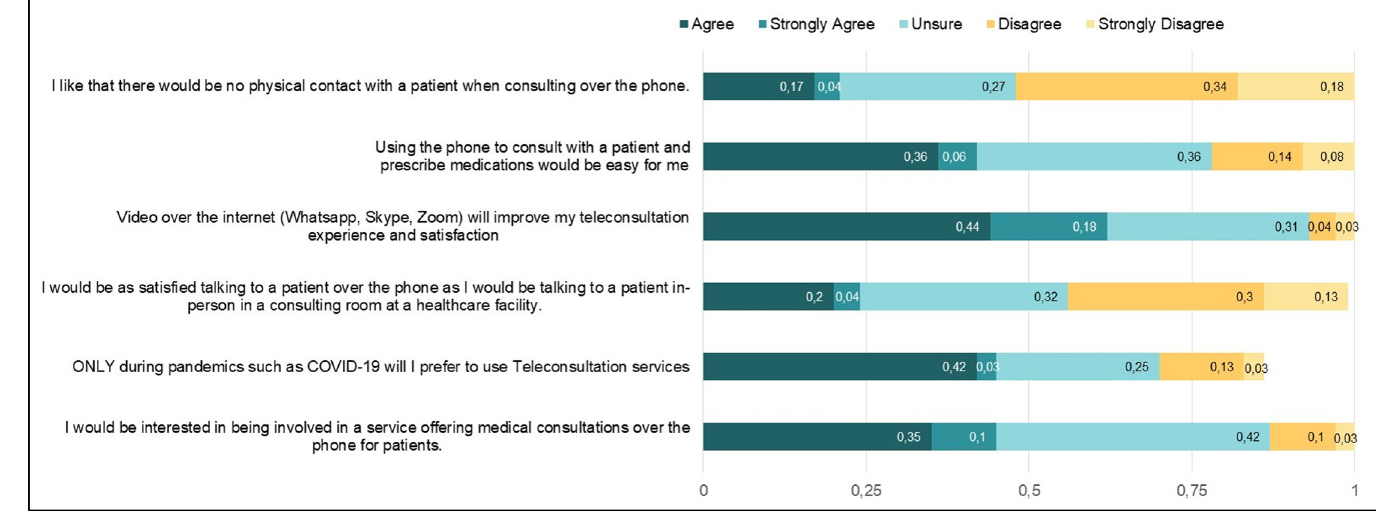
Fig 1. Overall perceptions on the use of telemedicine among healthcare